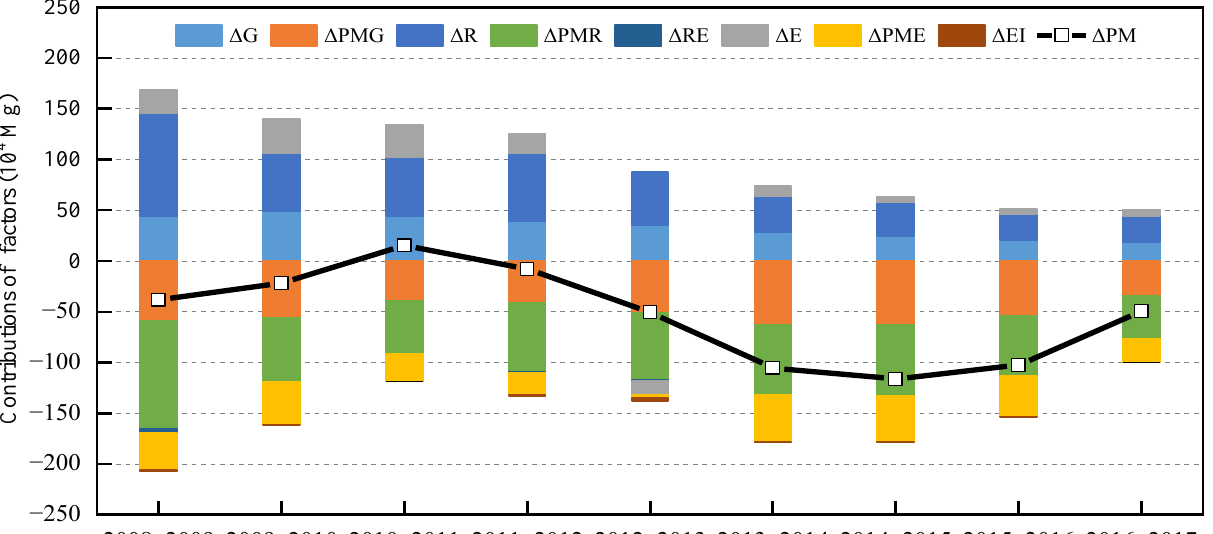
Figure 1. Decomposition results in China from 2008 to 2017 (Δ G , Δ PMG , Δ R , Δ PMR , Δ RE , Δ E , Δ PME , and Δ EI denote the effects of changes in GDP, emission intensity, innovation input scale, innovation input PM 2.5 intensity, innovation input efficiency, energy consumption scale, emission coefficient, and energy intensity on the changes in PM 2.5 emissions, respectively. Δ PM indicates the changes in PM 2.5 emissions).